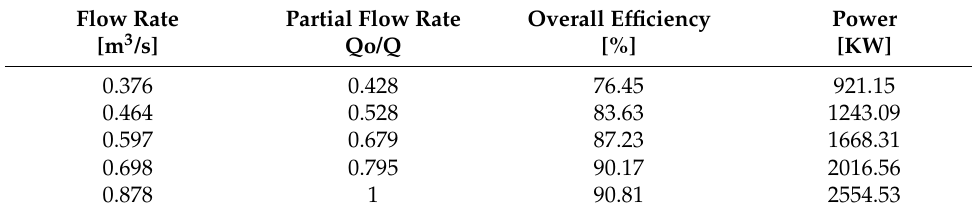
Table 5. Results of parametric model.